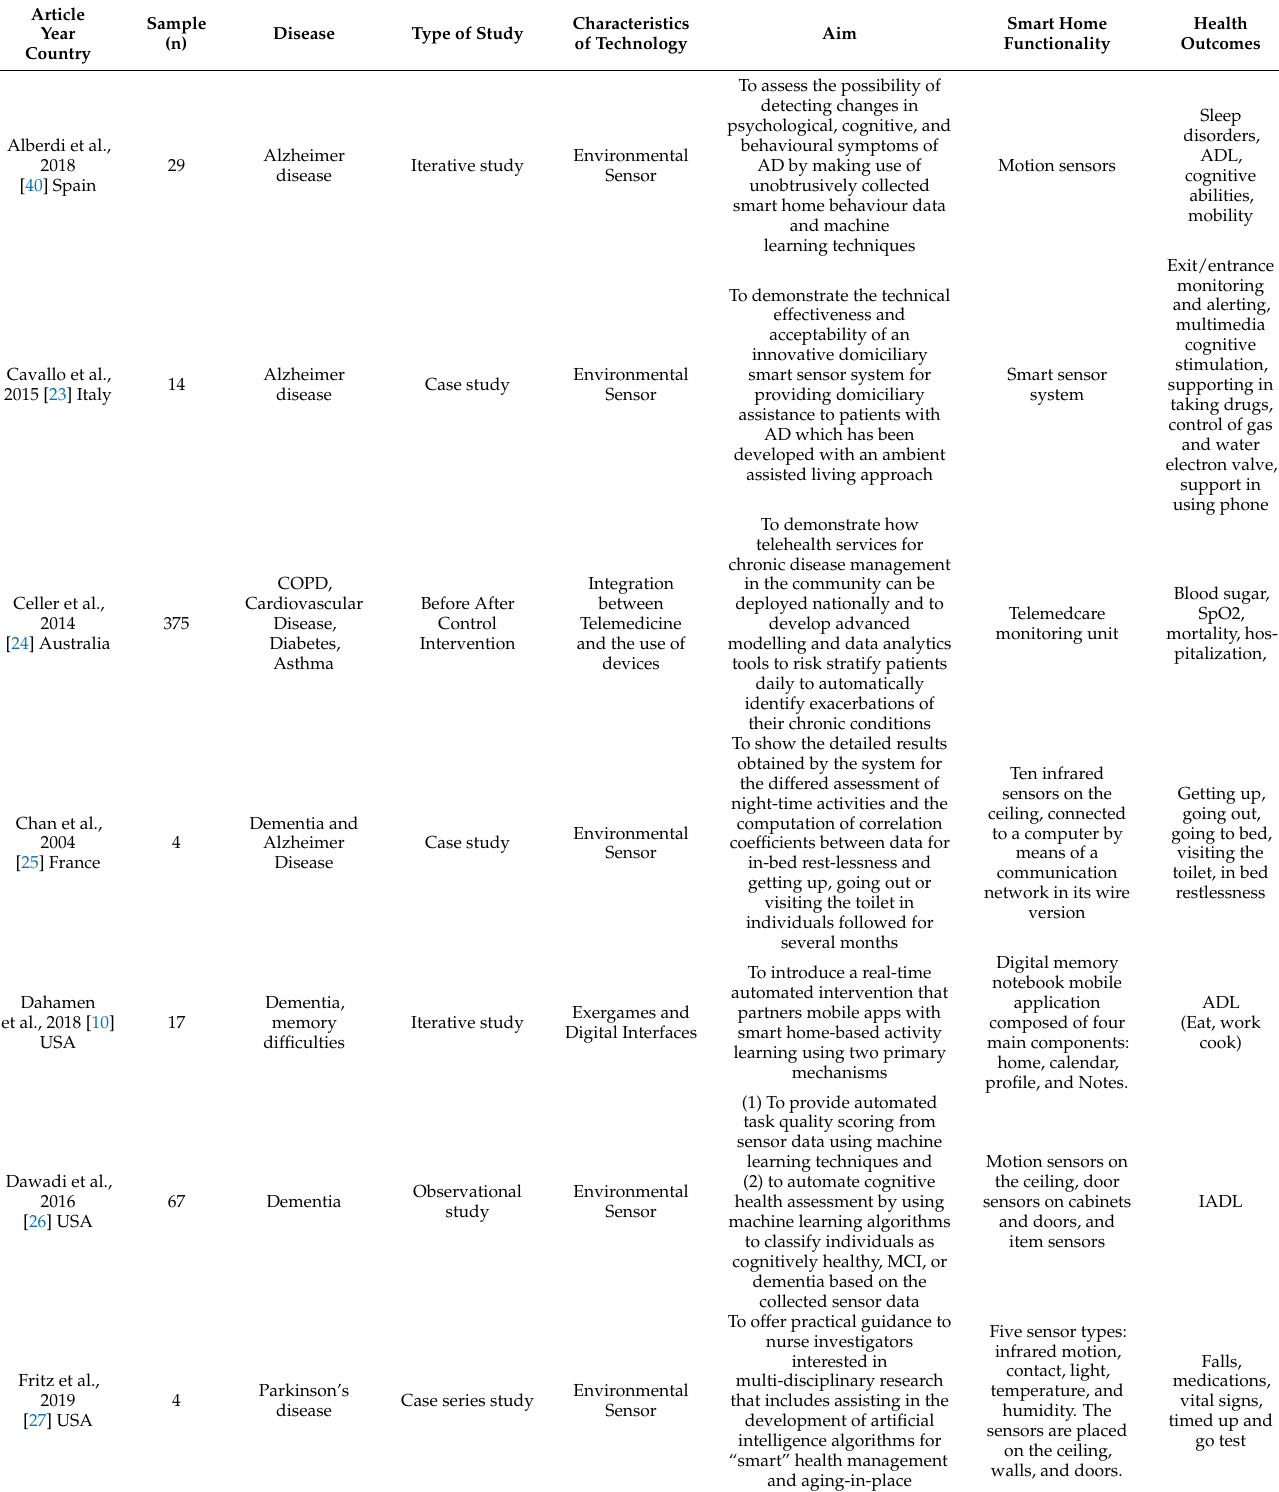
Table 2. Characteristics of the included studies (n =